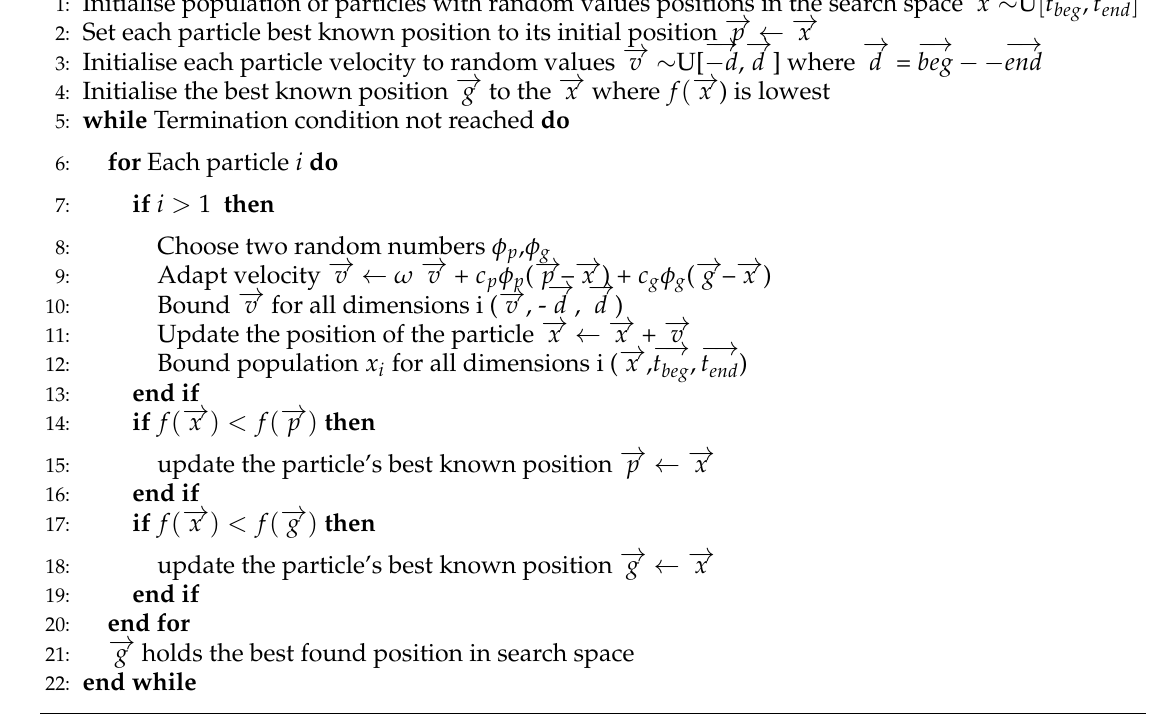
Algorithm 6 Optimisation based on PSO